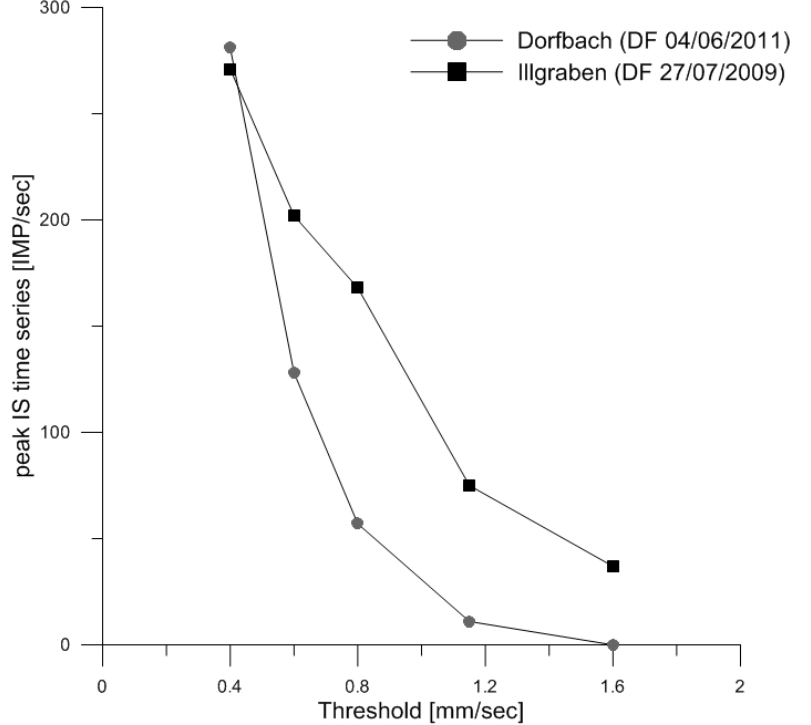
Figure 10. Relation between the threshold value in mm/s and the peak value of the IS time series obtained from the different cases of Figure